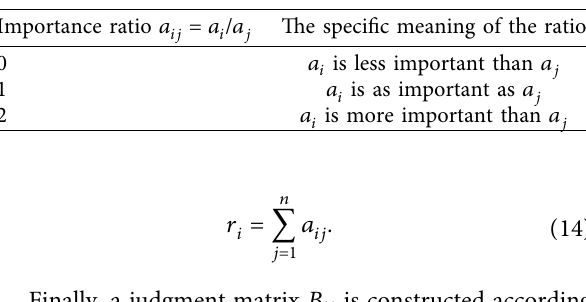
Table 2: The importance ratio and meaning of evaluation indicators.